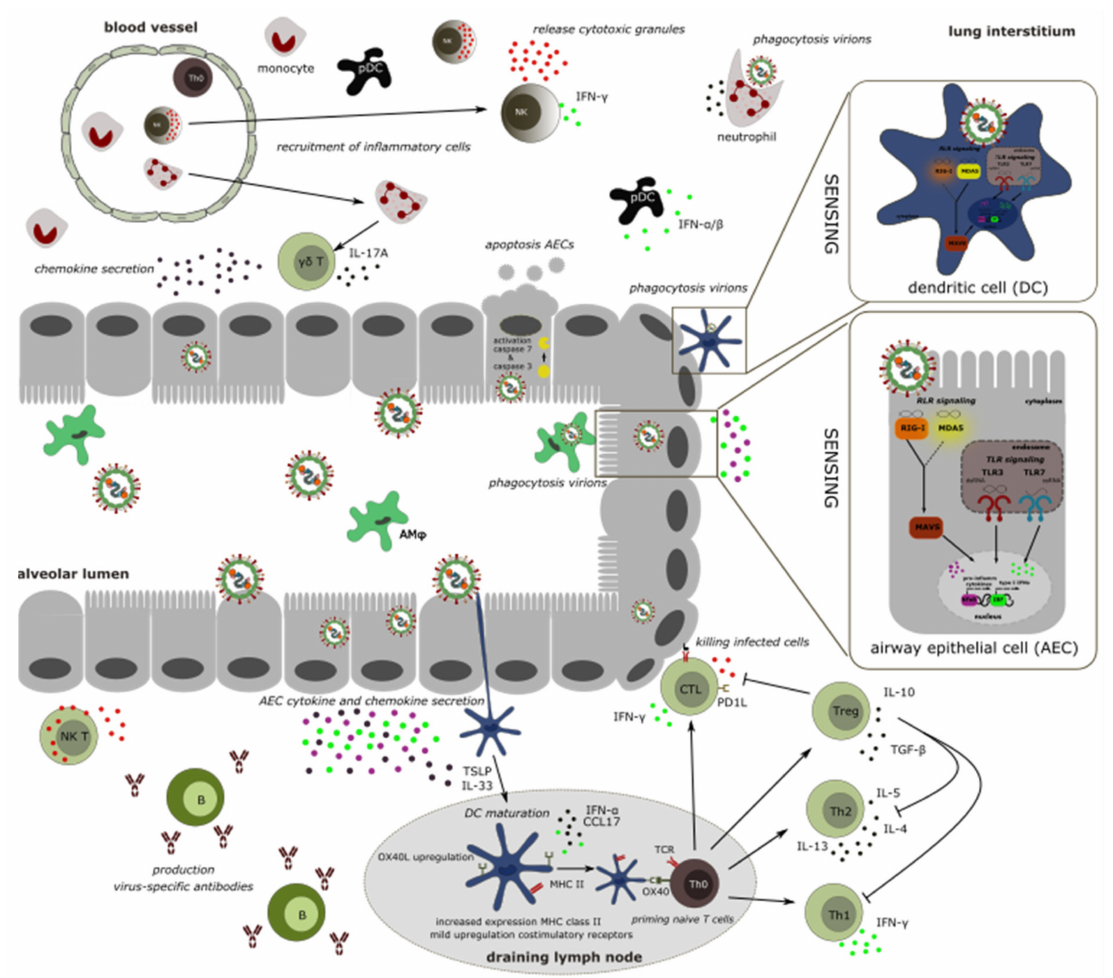
Figure 2. Schematic overview of the interplay between di ff erent cell types leading to pulmonary immunopathology upon hMPV infection described in this review. Briefly, dendritic cells (DC), airway epithelial cells (AECs) and alveolar macrophages (AM ϕ ) are the major cell populations that sense hMPV infections. AM ϕ initiate the primary innate immune response and viral clearance by phagocytosis of hMPV virions. Infected AECs release several pro-inflammatory cytokines, chemokines, and interferons (IFNs) and eventually undergo apoptosis. The signaling pathways induced upon hMPV infection are presented in the zoomed-in box on the right. Activated DCs can stay in the lung and promote local immune responses or they can migrate to the draining lymph nodes and prime naïve T cells (Th0). The activated e ff ector CD4 + and CD8 + T cells expand and migrate back to the lung. Th0 cells can di ff erentiate into several T cell subsets upon hMPV infection including Th1, Th2, regulatory T cells (Tregs), NKT cells, and cytotoxic lymphocytes (CTLs). The last two subsets are able to kill infected cells by the release of cytotoxic granules. Chemokine release by infected AECs recruits several other inflammatory cell types such as NK cells, monocytes, and neutrophils, mediating viral clearance via various killing mechanisms. Another important step in the control of viral infection later in the infection is humoral response through the production of virus-specific antibodies by B